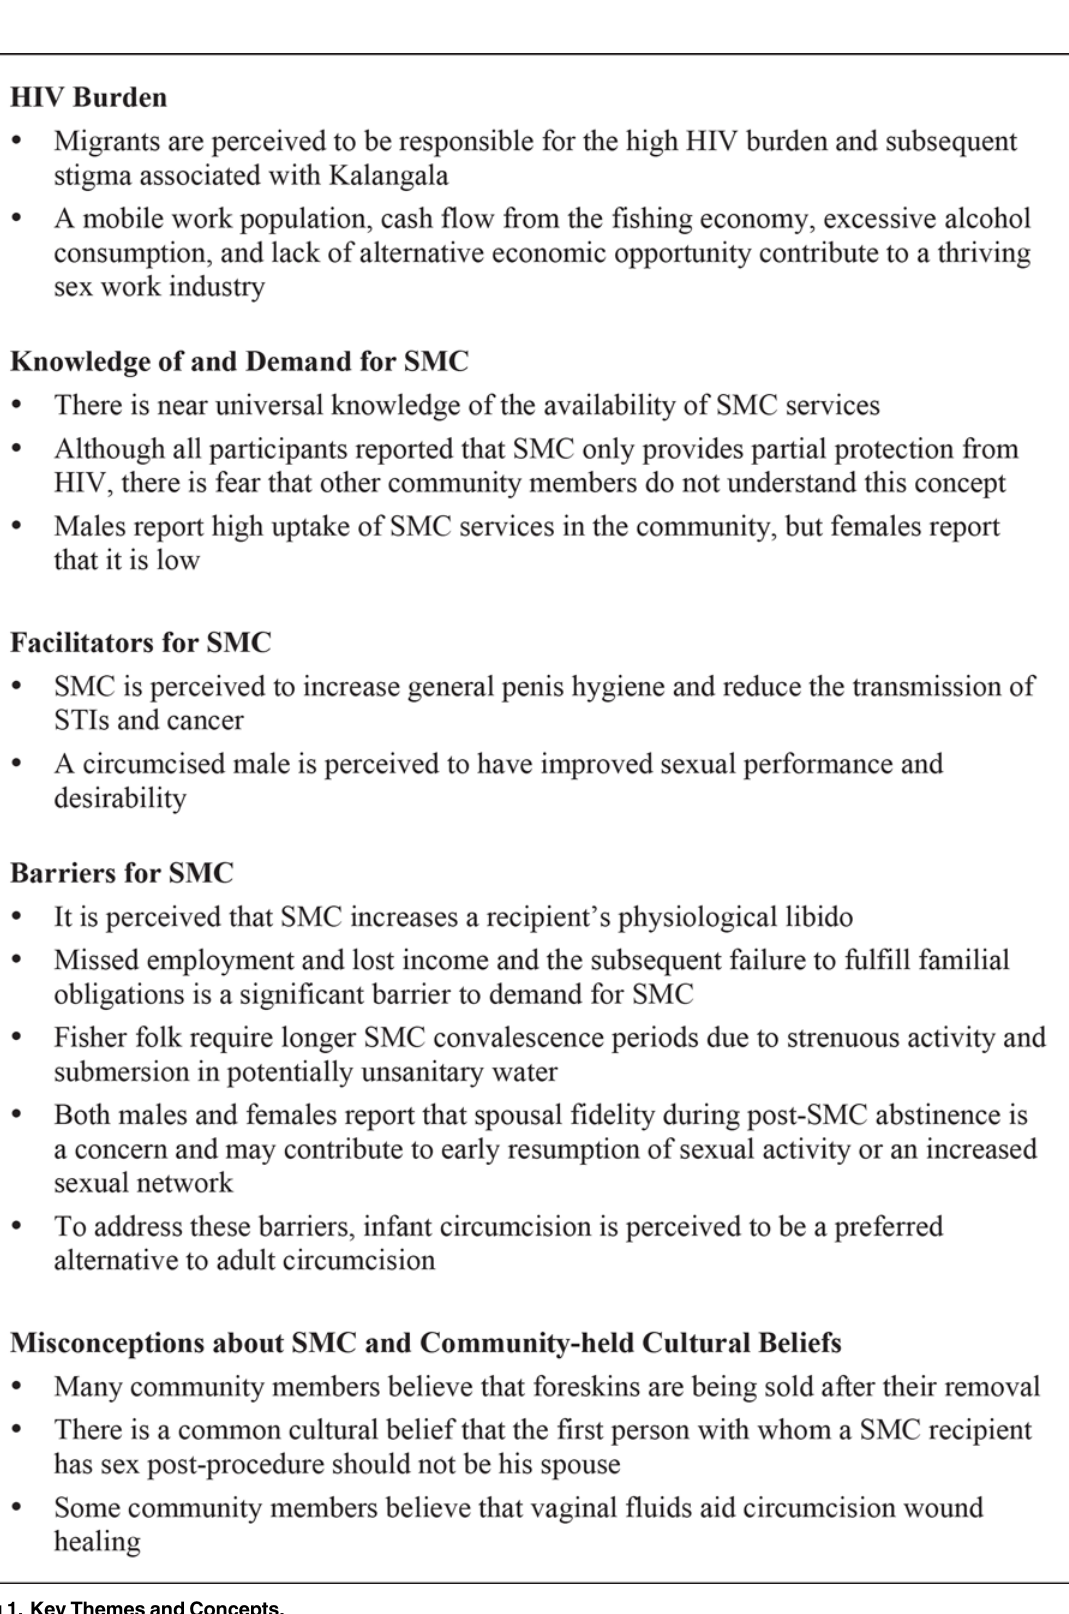
Fig 1. Key Themes and